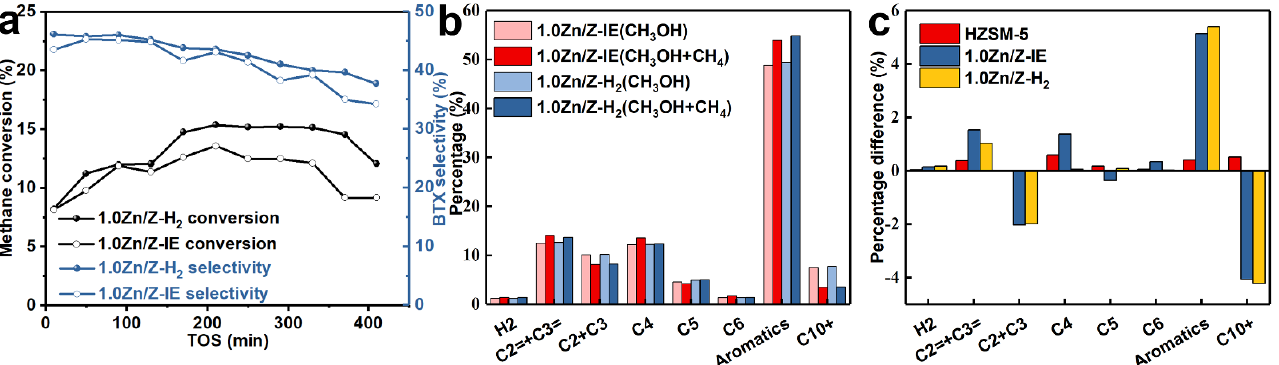
Figure 7. Methane conversions and BTX selectivities of 1.0Zn/Z-H 2 and 1.0Zn/Z-IE with time on stream in co-reaction ( a ); aromatic selectivities of MTA and co-reaction over 1.0Zn/Z-H 2 and 1.0Zn/Z-IE ( b ); difference of product distribution between co-reaction and MTA reaction over 1.0Zn/Z-H 2 and 1.0Zn/Z-IE ( c ) (0.67 g catalyst, 37.1 mL·min −1 N 2 flow rate in MTA reaction or 37.1 mL·min −1 mixed gas of N 2 and CH 4 , 0.045 mL·min −1 methanol flow rate, the methanol to methane molar ratio is 1.3, average data calculated by performance at 10 min, 50 min, 90 min).